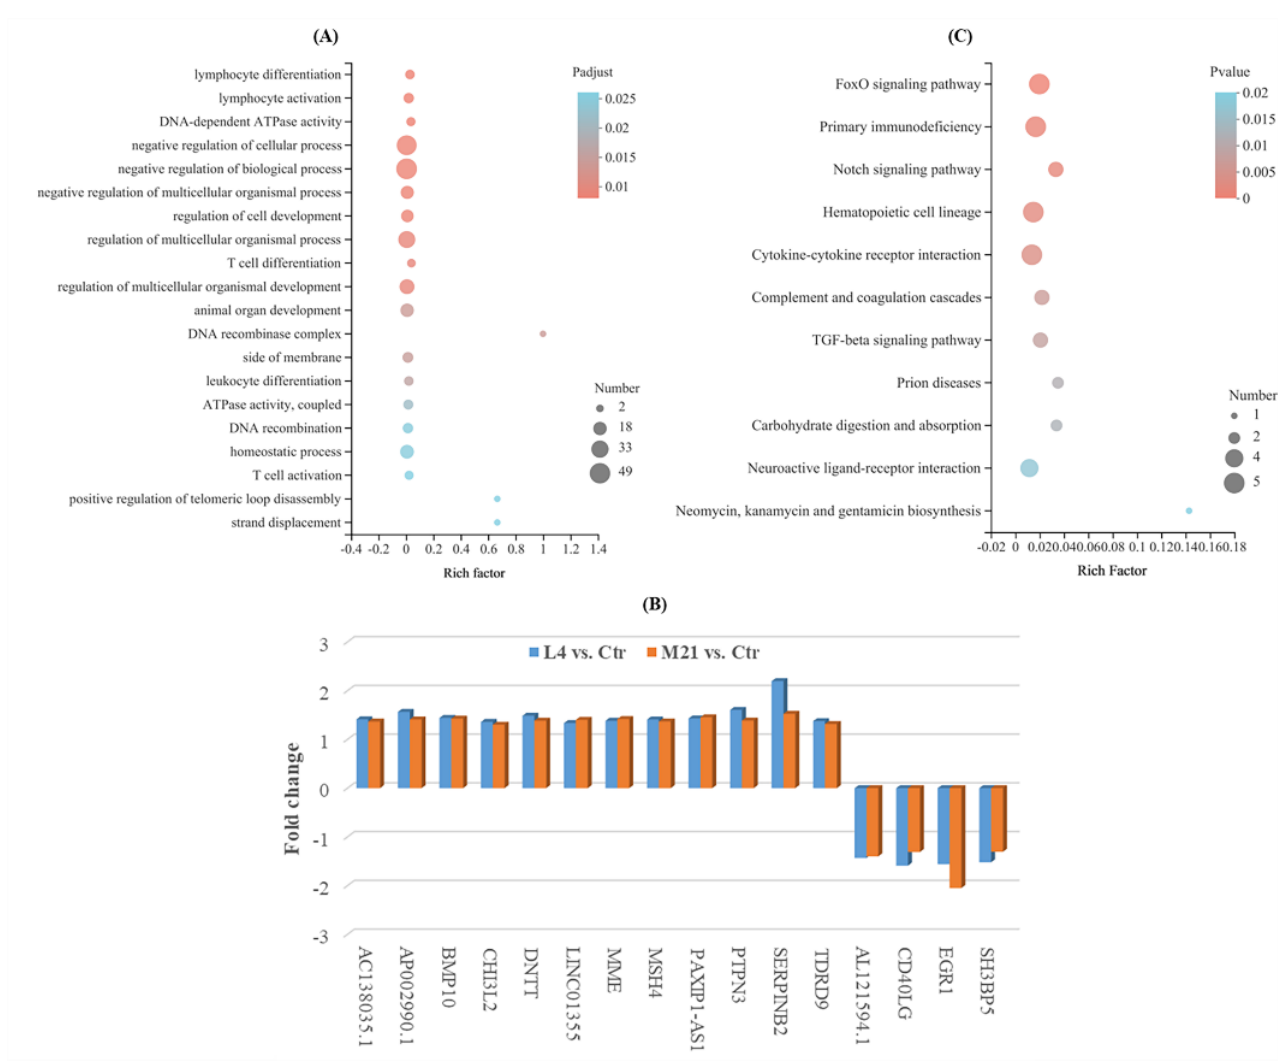
Figure 5. Gene ontology enrichment analysis for the significantly differentially expressed genes ( A ), simultaneously significantly different expressed genes for both comparison of L4 vs. Ctr and M21 vs. Ctr ( B ), and KEGG enrichment analysis for the significantly differentially expressed genes ( C ).